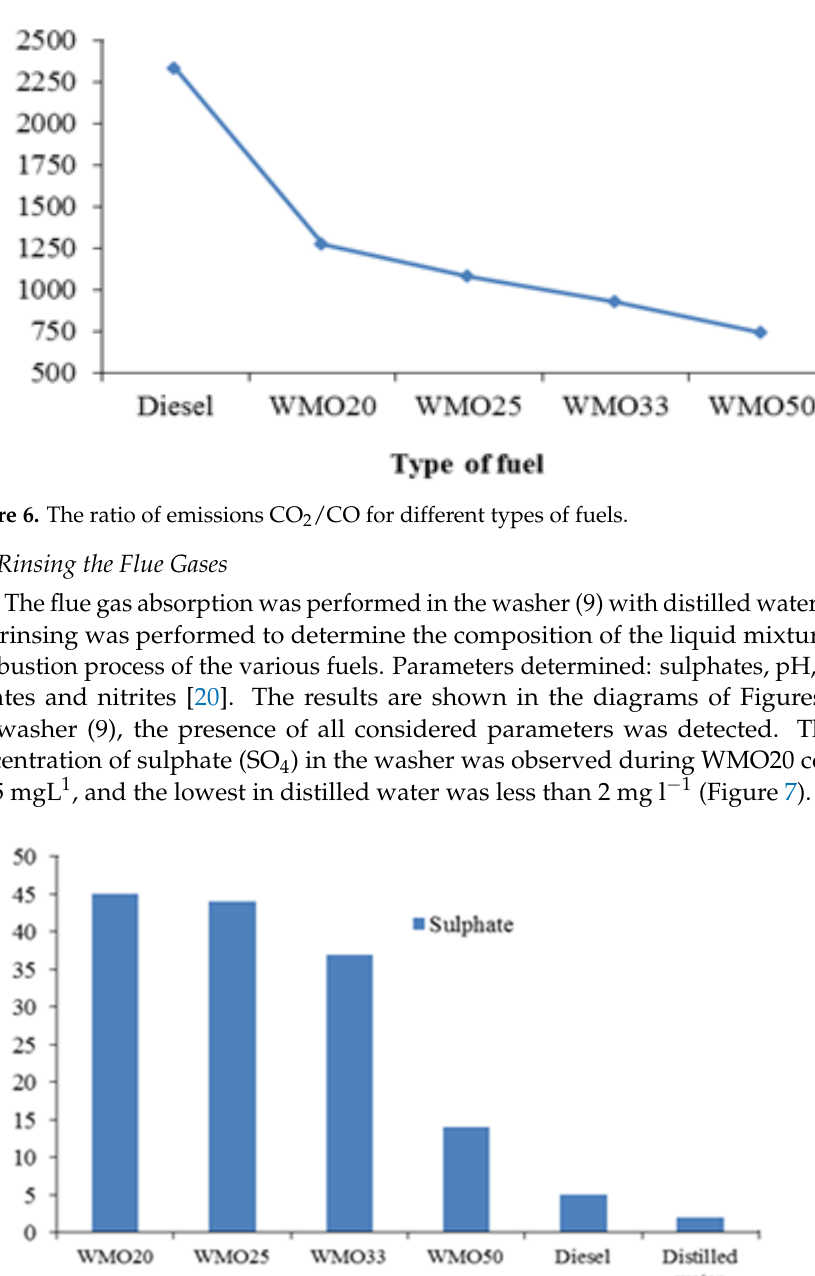
Figure 7. Sulphate fraction in the solution during the flue gas purification for different fuel types.